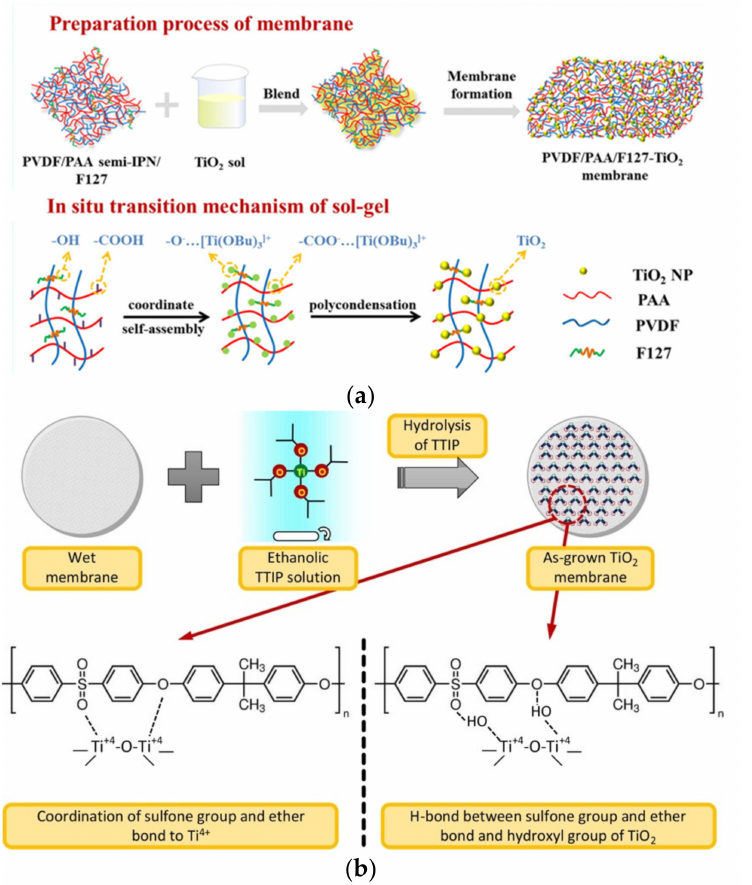
Figure 3. Schematic illustration of ( a ) the blending of TiO 2 sol with polymer dope and the in situ transition mechanism of sol–gel to form TiO 2 nanoparticles [116] and ( b ) the in situ hydrolysis of TiO 2 precursor on the polymer backbone [118]. Reprinted with